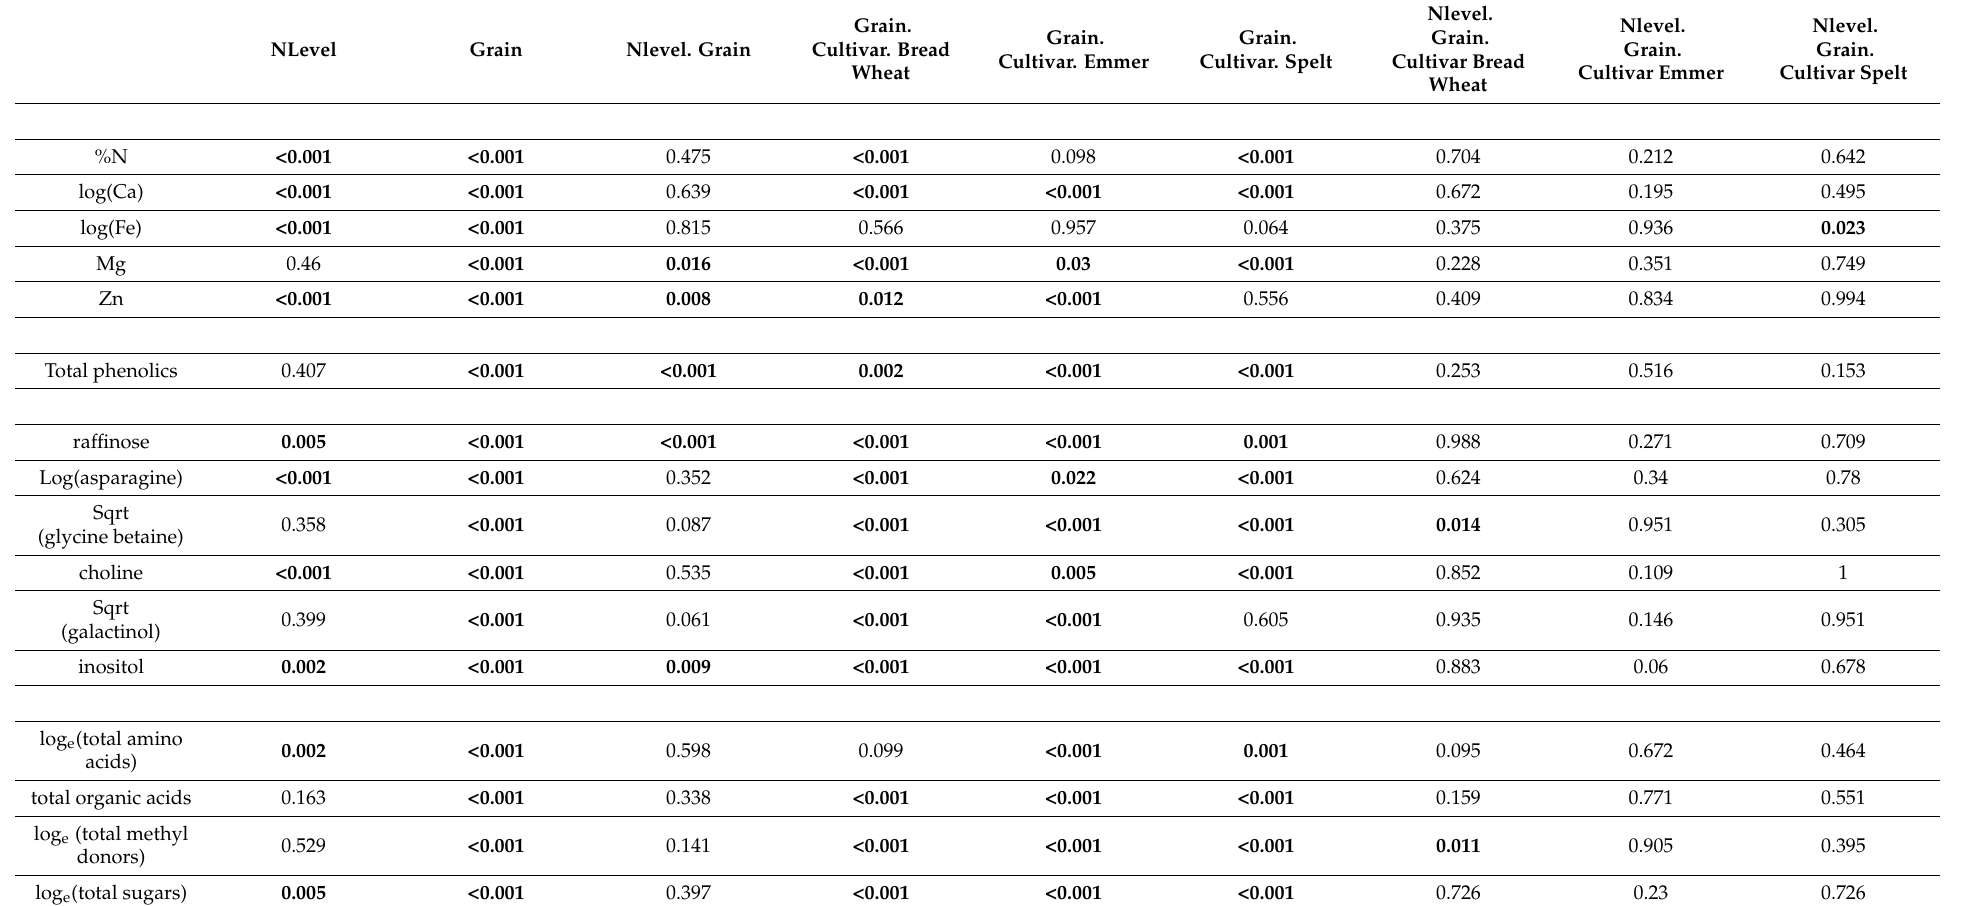
Table 2. p values from ANOVA of minerals and selected metabolites in the three cereal types and cultivars. NLevel Grain Nlevel. Grain